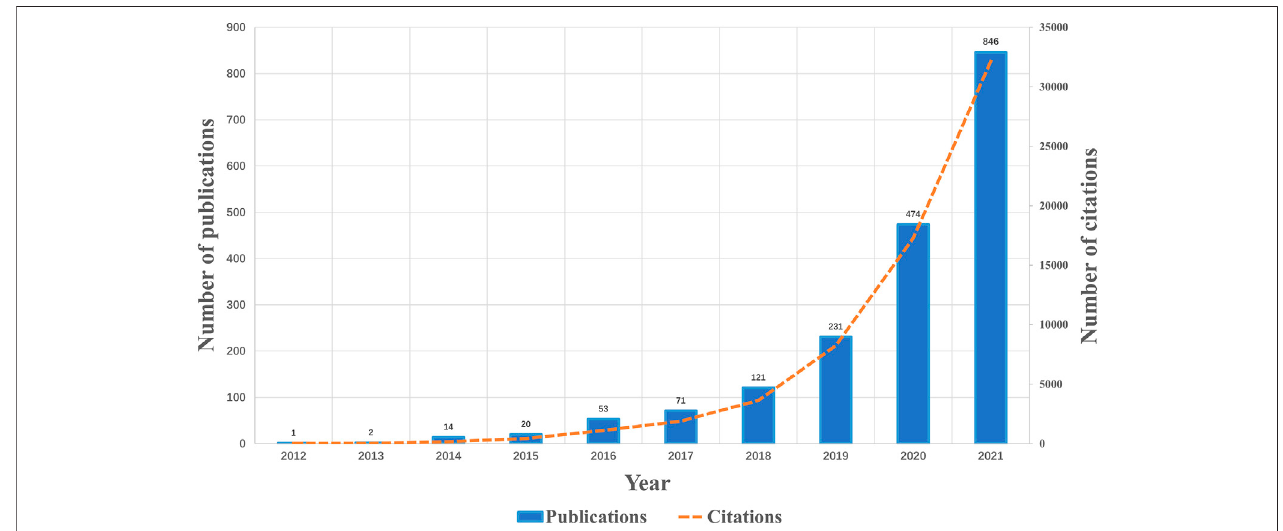
FIGURE 1 | Number of annual publications and citations of ferroptosis in cancer from 2012 to 2021.